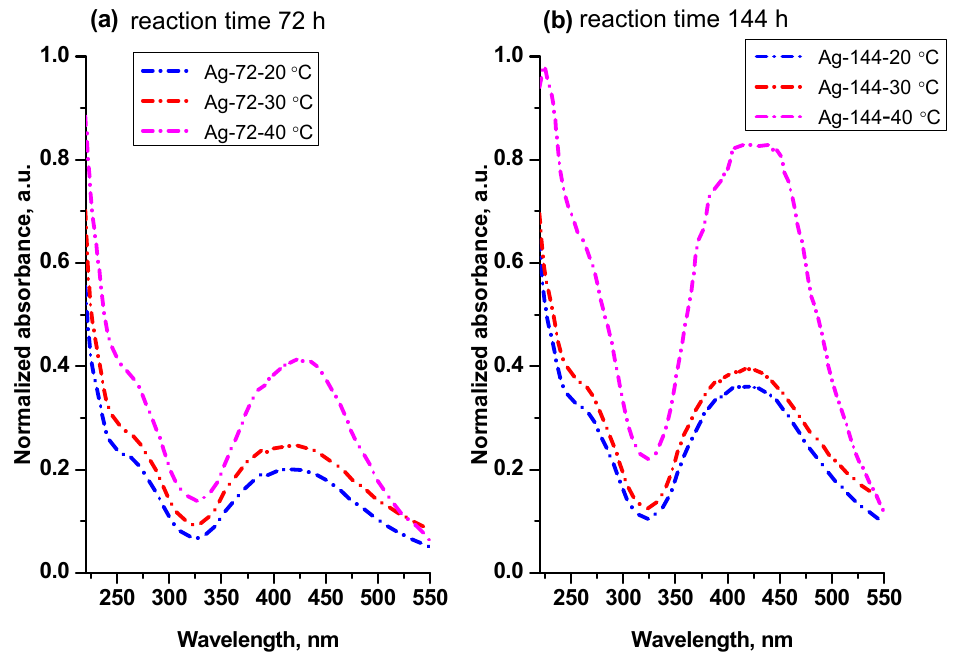
Figure 2. Temperature dependence of AgNP formation at 20, 30 and 40 ◦ C. UV–Vis spectra of aqueous dispersions of AgNPs isolated from the reaction mixture after 72 h reaction time ( a ) and 144 h reaction time ( b ).